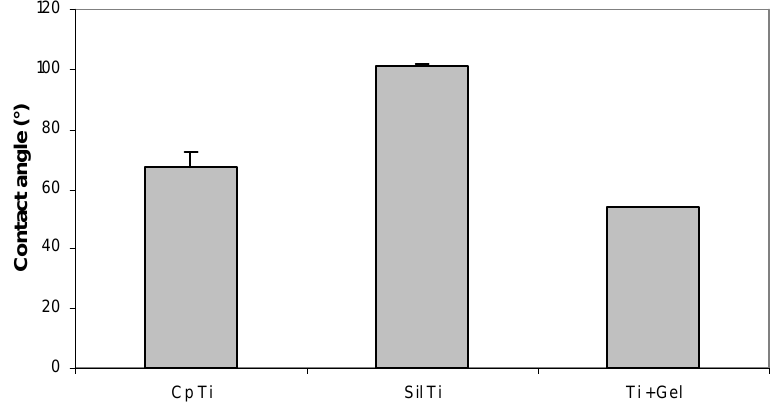
Figure 7. Static contact angle measurements of cp Ti, TMSPMA silanized Ti (Sil Ti) and gelatin-coated Ti (Ti + Gel). The values obtained are an average of three separate